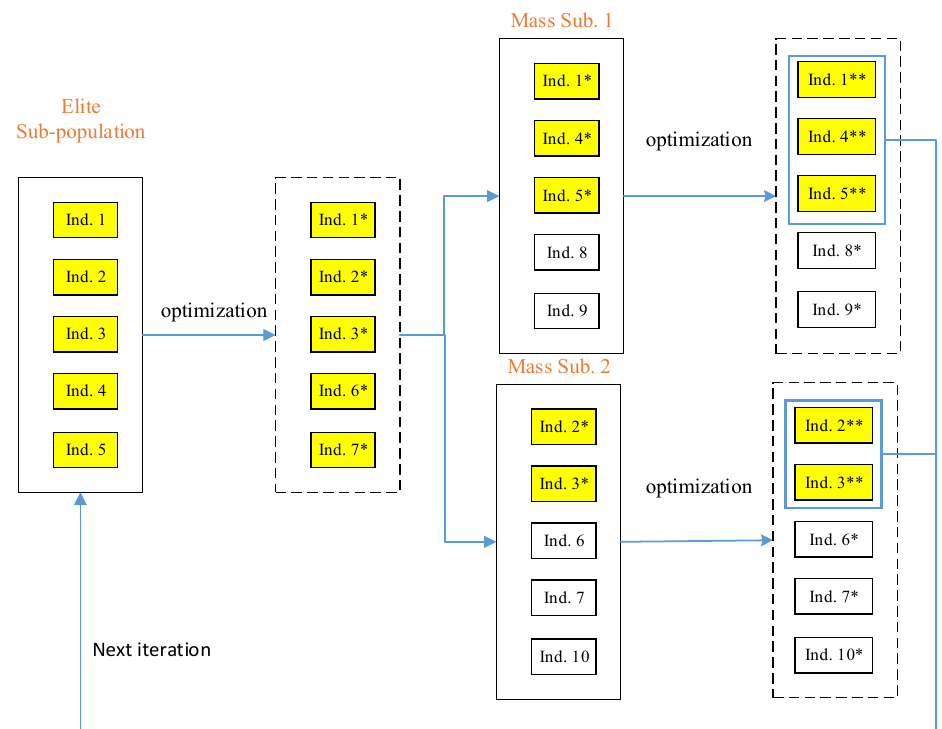
Figure 10. Optimization process of elite-mass population distribution.